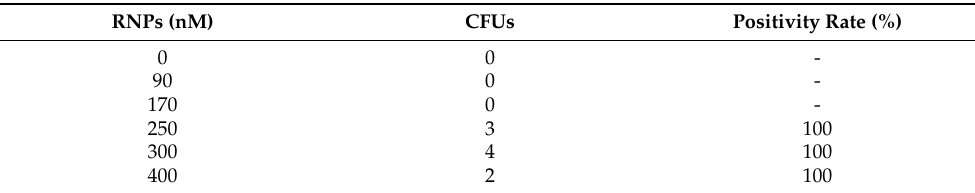
Table 4. Effect of the RNPs concentration on targeting